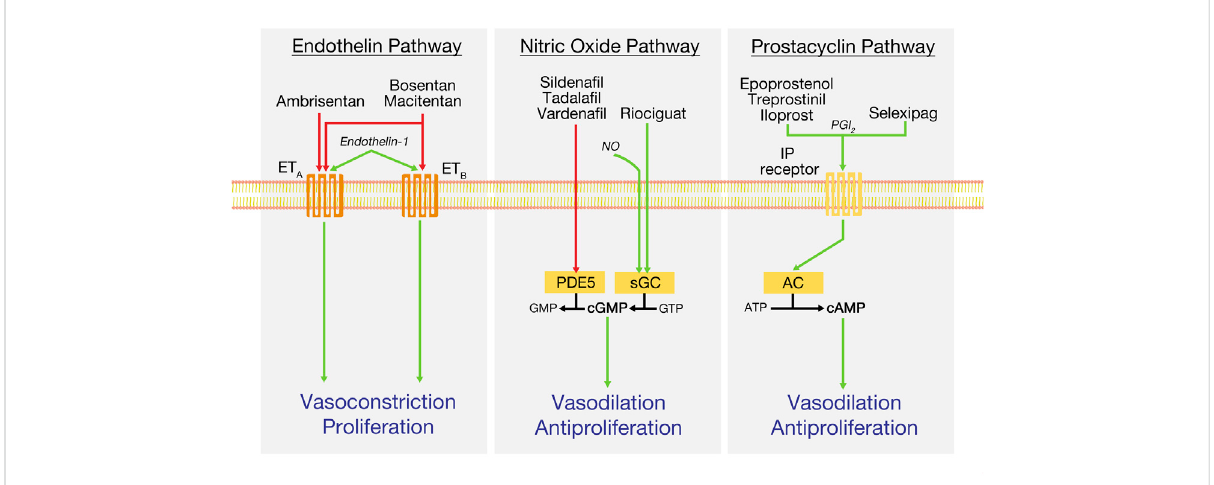
FIGURE 1 Keytreatmentpathwaysinthecurrentmanagementofpulmonaryarterialhypertension.Greenarrowsindicatepathwaystimulation;redarrows indicate inhibition. AC, adenylyl cyclase; cAMP, cyclic adenosine monophosphate; ATP, adenosine triphosphate; cGMP, cyclic guanosine monophosphate; ET A and ET B , endothelin receptors; GMP, guanosine monophosphate; IP, prostacyclin receptor; NO, nitric oxide; PDE5, phosphodiesterase-5; PGI 2 , prostacyclin or prostaglandin I2; sGC, soluble guanylyl